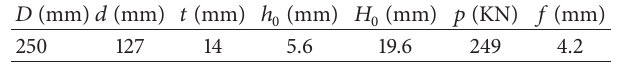
Table 1: Belleville spring